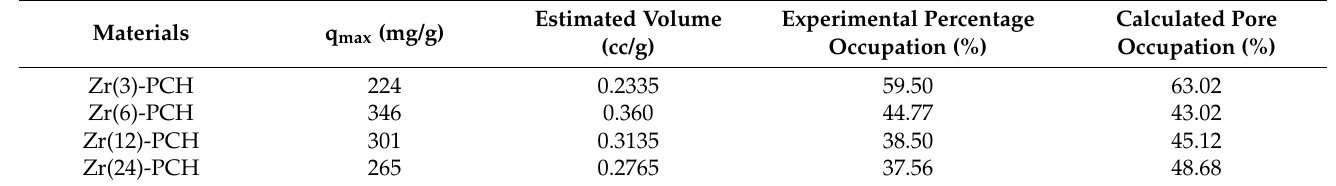
Table 6. Estimated volumes and percentage occupation of pores of the maximum removed amounts (q max ) of basic blue-41 by Zr(X)-PCH materials.